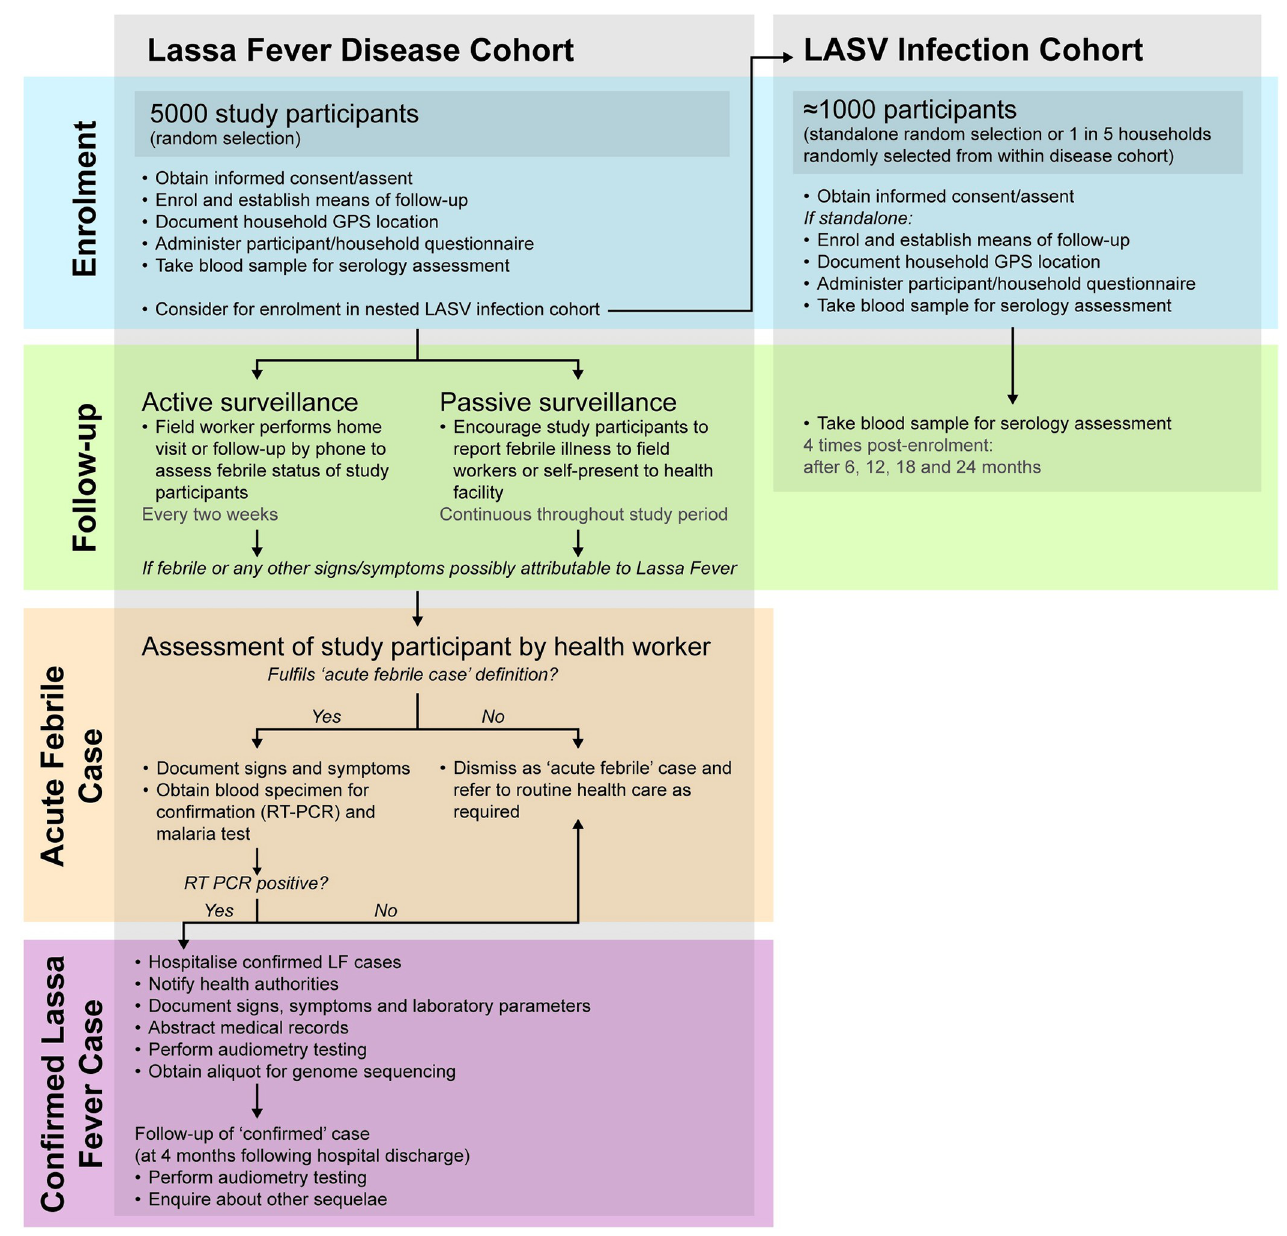
Fig 1. Study flow